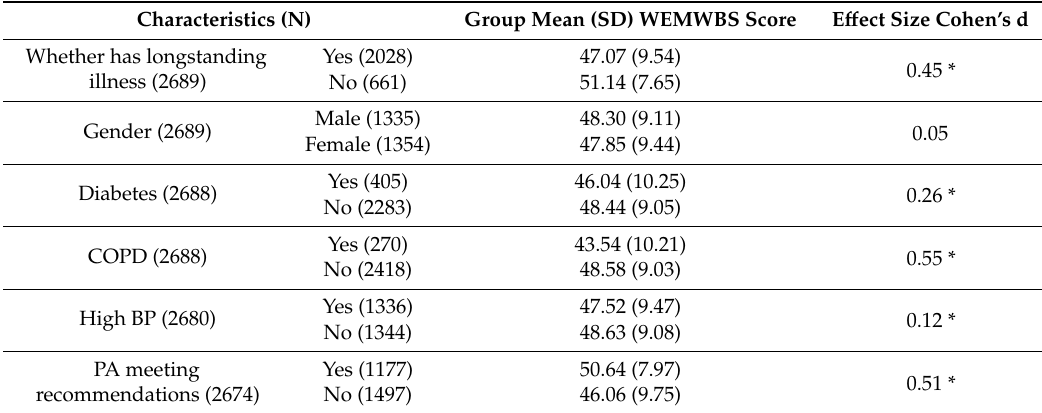
Table 2. Mean di ff erences of WEMWBS scores among selected categorical variable groups.